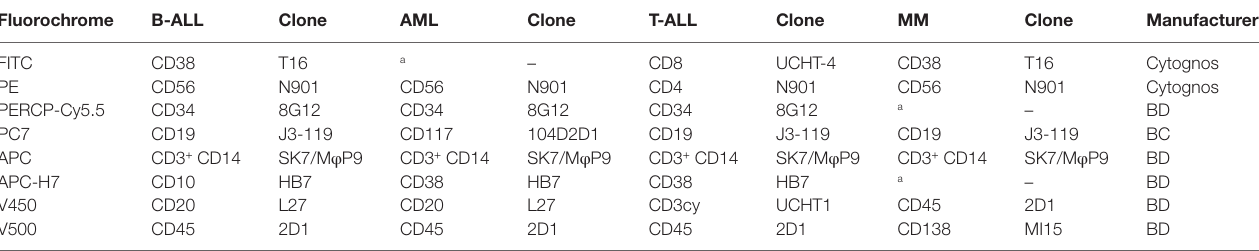
Table 2 | Antibodies used to investigate infiltration of hematologic malignancy in the central nervous system. Fluorochrome